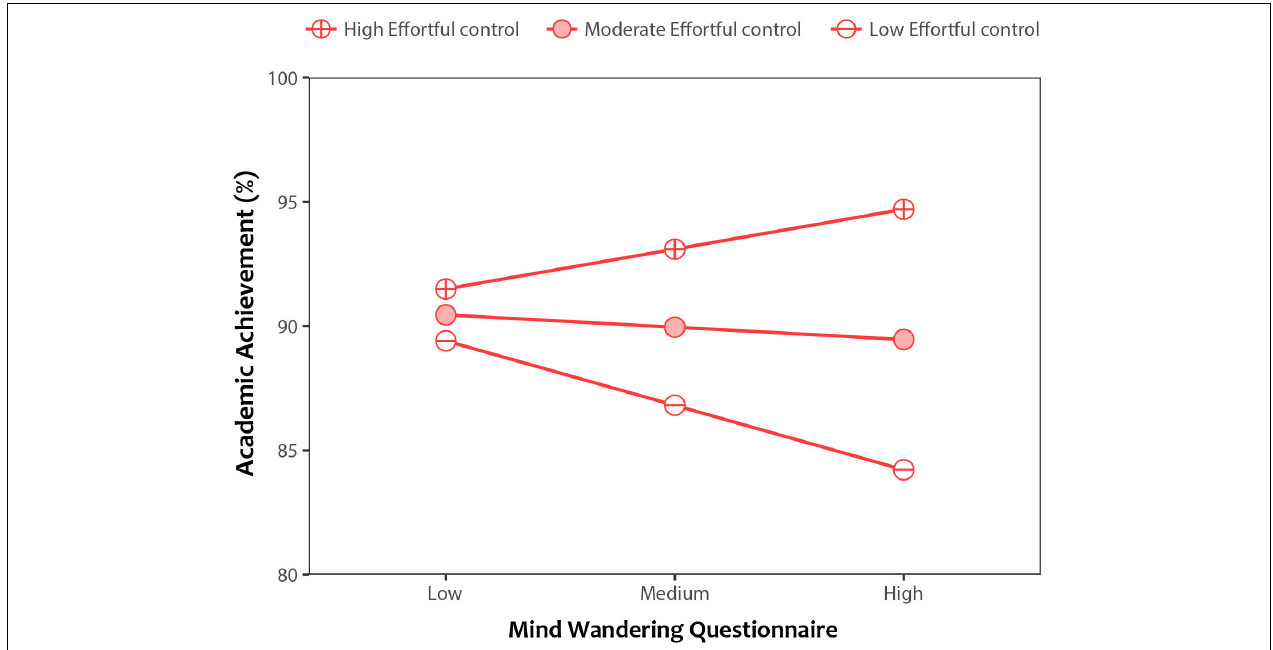
FIGURE 3 | An interaction plot depicting the relationship between trait scores on the Mind Wandering Questionnaire and academic achievement, as moderated by the temperament trait of Effortful control. Simple slopes illustrate the moderating effect of high (+1SD above the mean), moderate (mean), and low (–1SD below the mean) Effortful